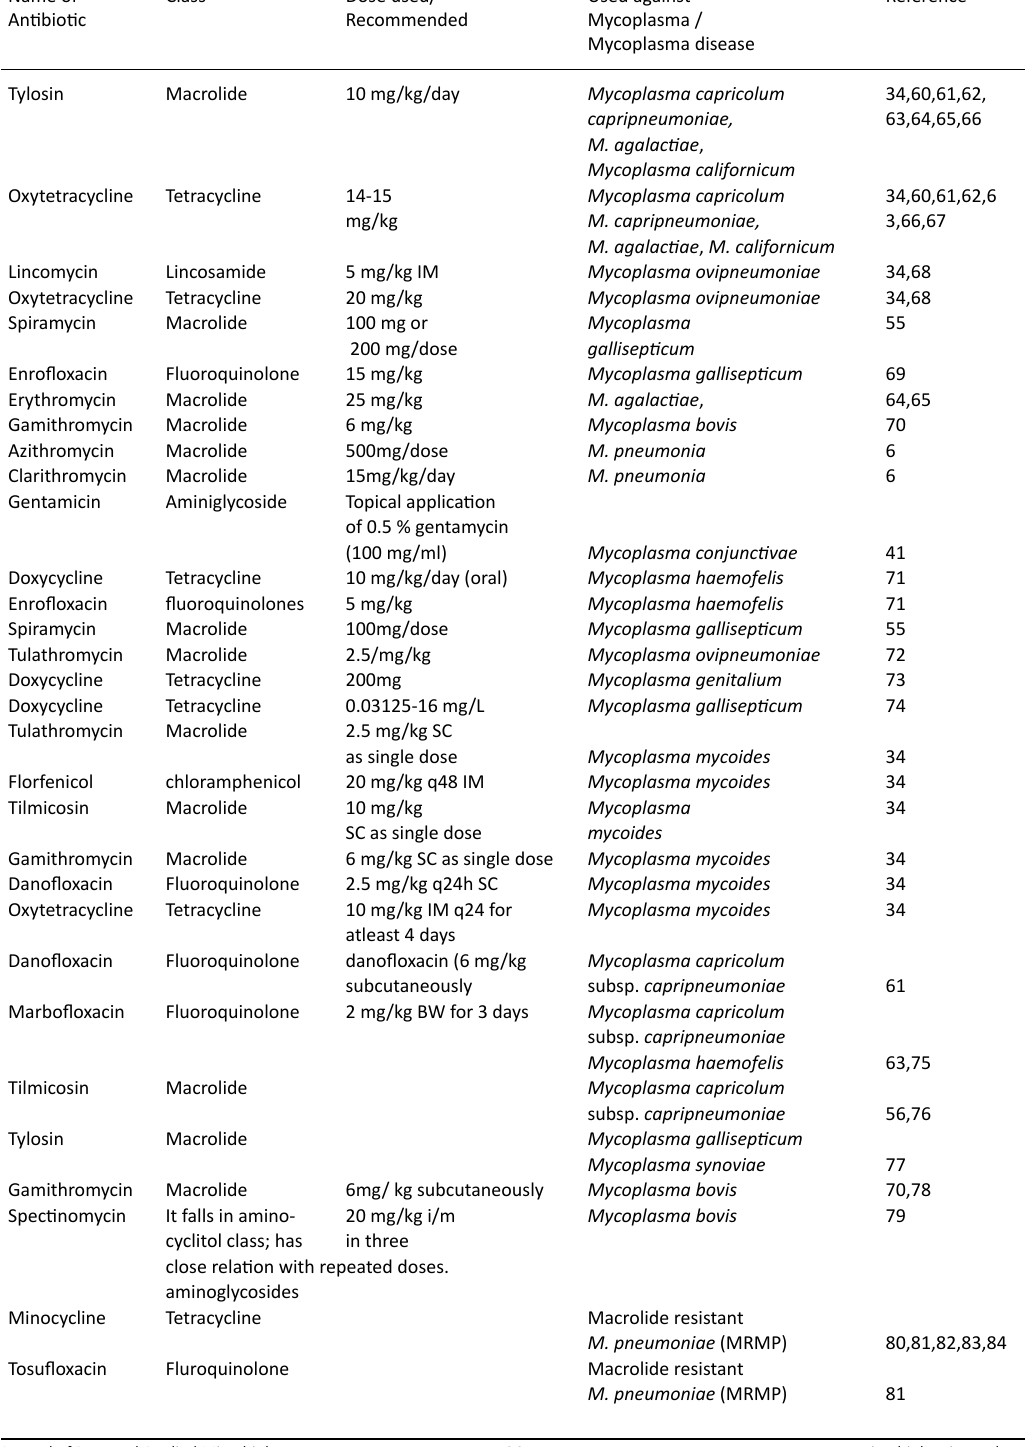
Table 1. Antimycoplasma antibiotics used in various mycoplasma